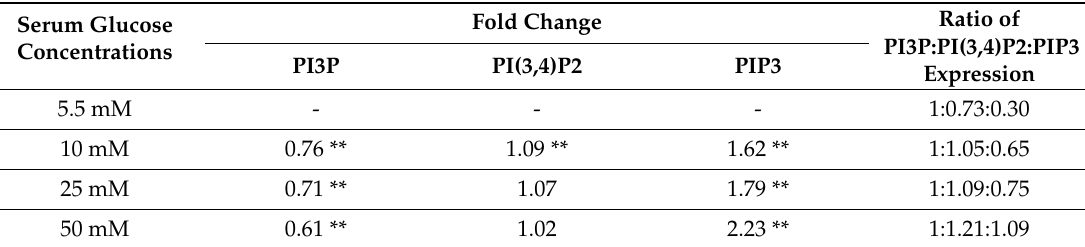
Table 7. Analysis of TNBC cell surface